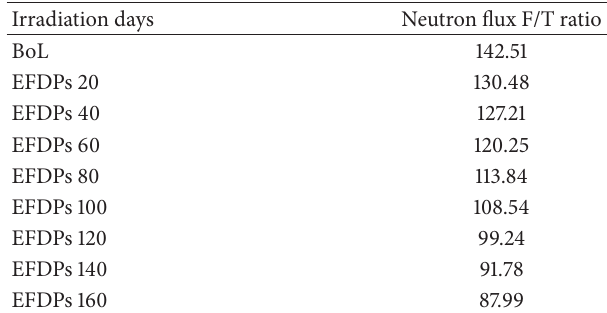
Table 3: Fast ( > 0.1MeV) to thermal (here < 0.415 eV) neutron flux ratios versus irradiation EFPDs at ITV